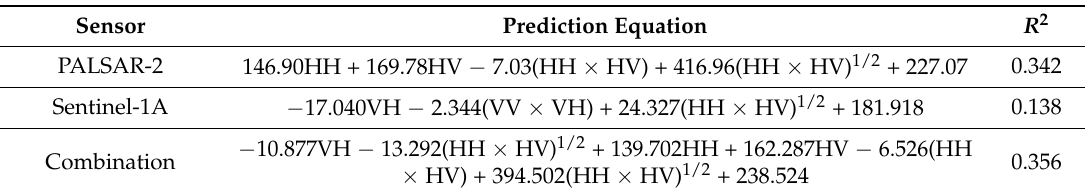
Table 8. The best correlations derived from multiple regression from a single sensor and combination of